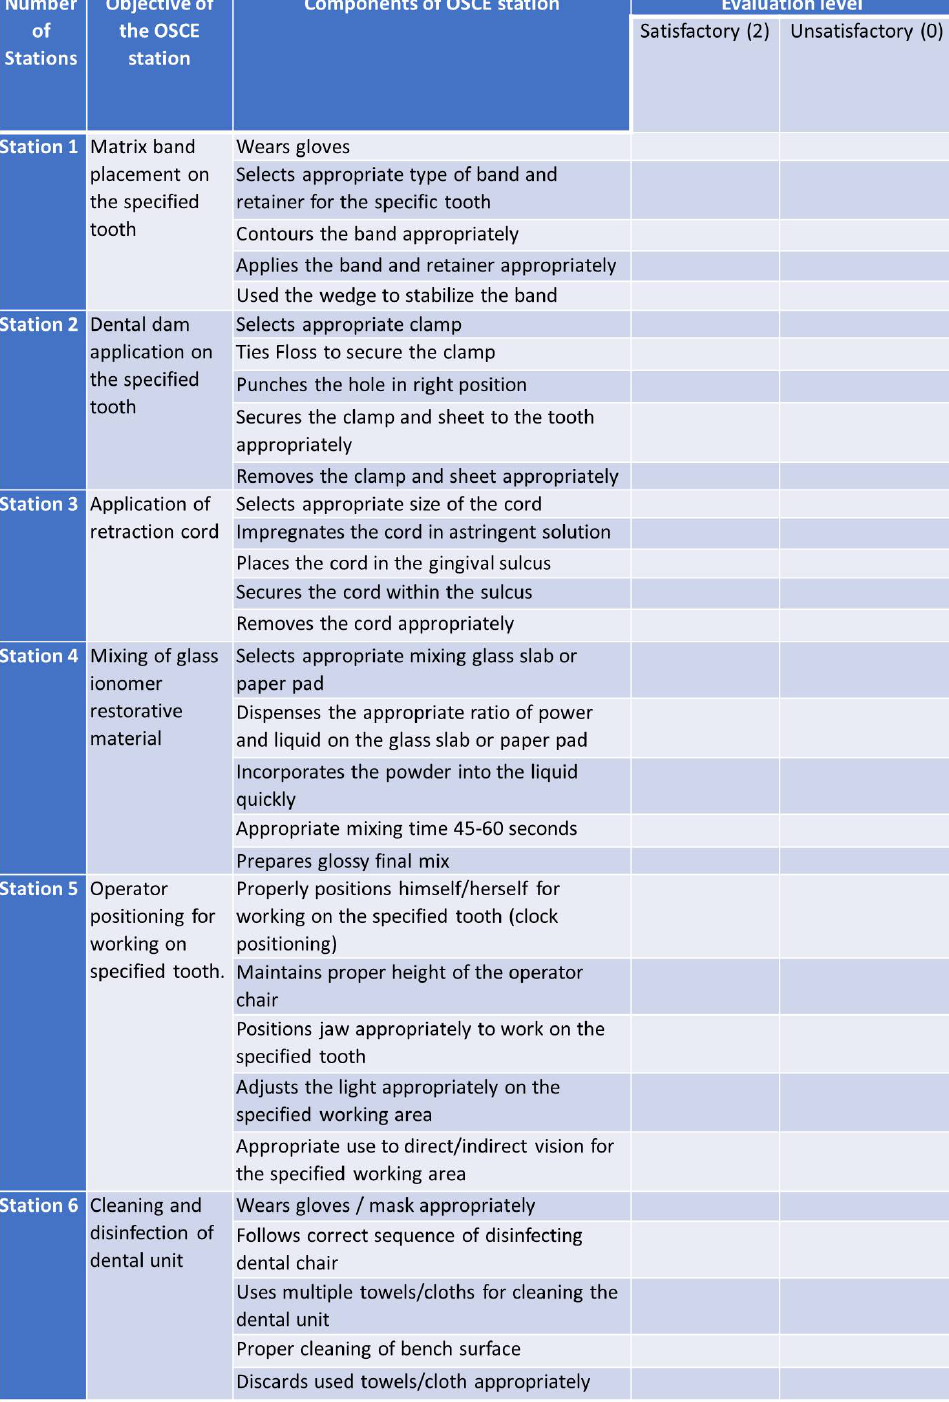
Figure 2. Sample description of objective structured clinical examination (OSCE) stations. Table 1. Comparison of OSCE station scores with respect to Group A and Group B.